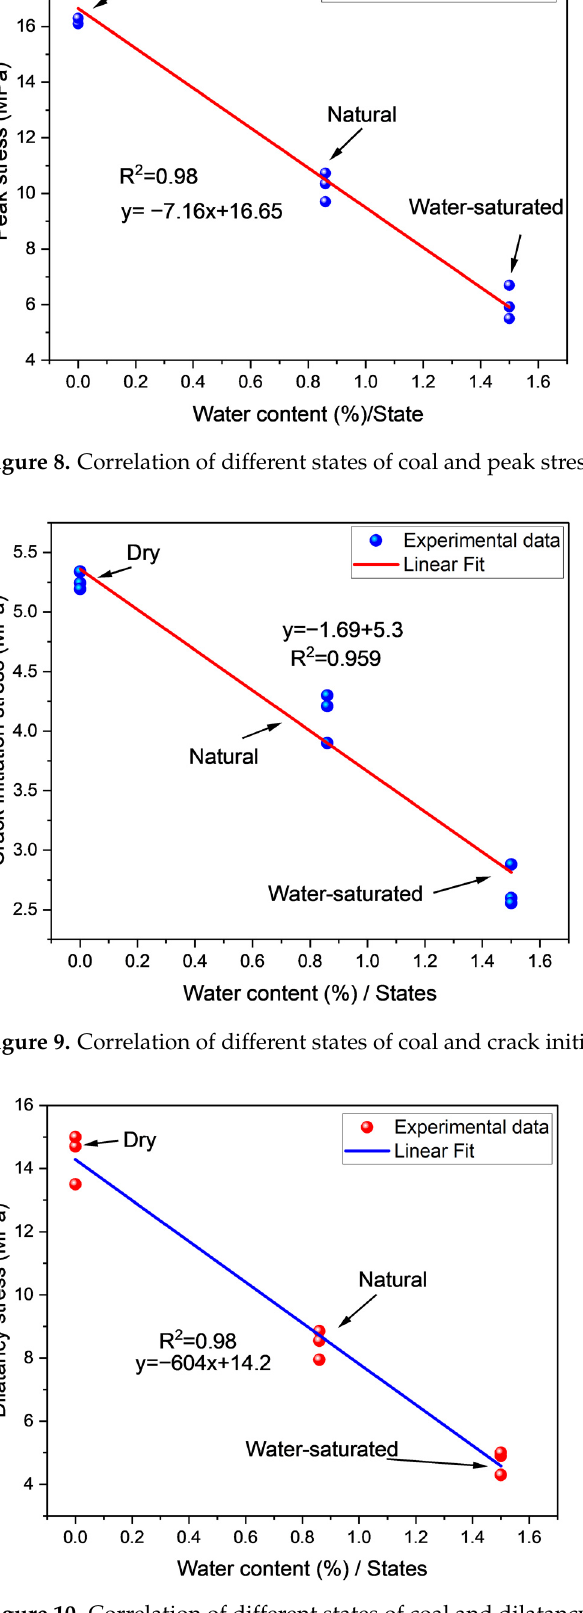
Figure 10. Correlation of different states of coal and dilatancy stress.